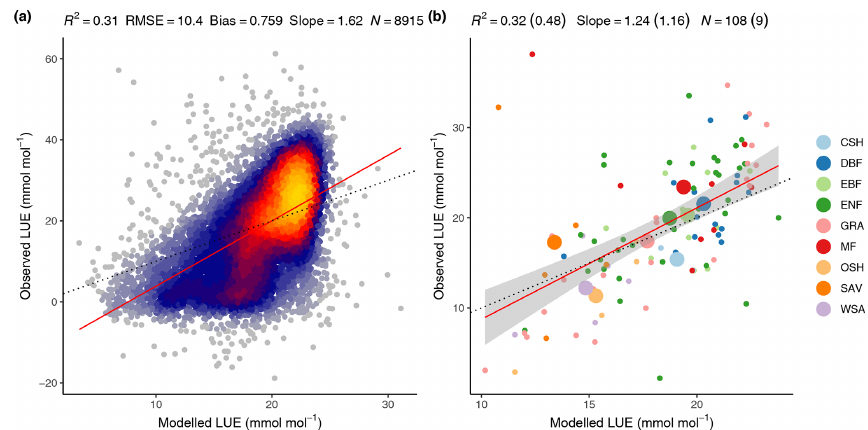
Figure 9. Modelled (FULL) versus observed LUE. (a) Mean monthly LUE with data pooled from all sites and available years. (b) Mean annual LUE by site (small dots and colour) and vegetation type (large dots and colour). Model performance metrics are given at the top with numbers in brackets referring to the regression of data aggregated by vegetation types and non-bracketed numbers for data aggregated by sites. Dotted lines represent the 1 : 1 relationship, red lines represent the fitted linear regression to all data in panel (a) and the fitted linear regression to mean annual LUE by site in panel (b) . The grey band in panel (b) represents the 95% confidence interval of the linear regression. Vegetation types are closed shrubland (CSH); deciduous broadleaf forest (DBF); evergreen broadleaf forest (EBF); evergreen needleleaf forest (ENF); grassland (GRA); mixed deciduous and evergreen needleleaf forest (MF); open shrubland (OSH); savanna ecosystem (SAV); woody savanna